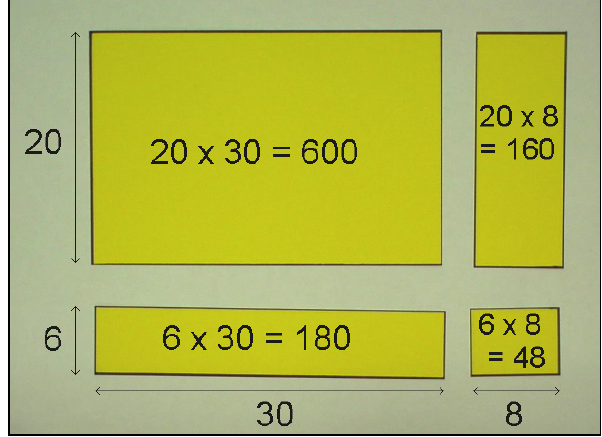
Figure 2 : Frame 35 from the video clip “rectangular